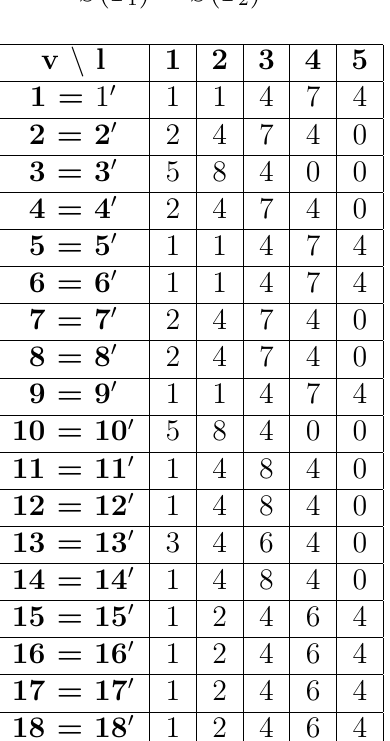
) = 𝑆 ( 𝑇 ) of the smallest Slater pair in Figure 1 1 2